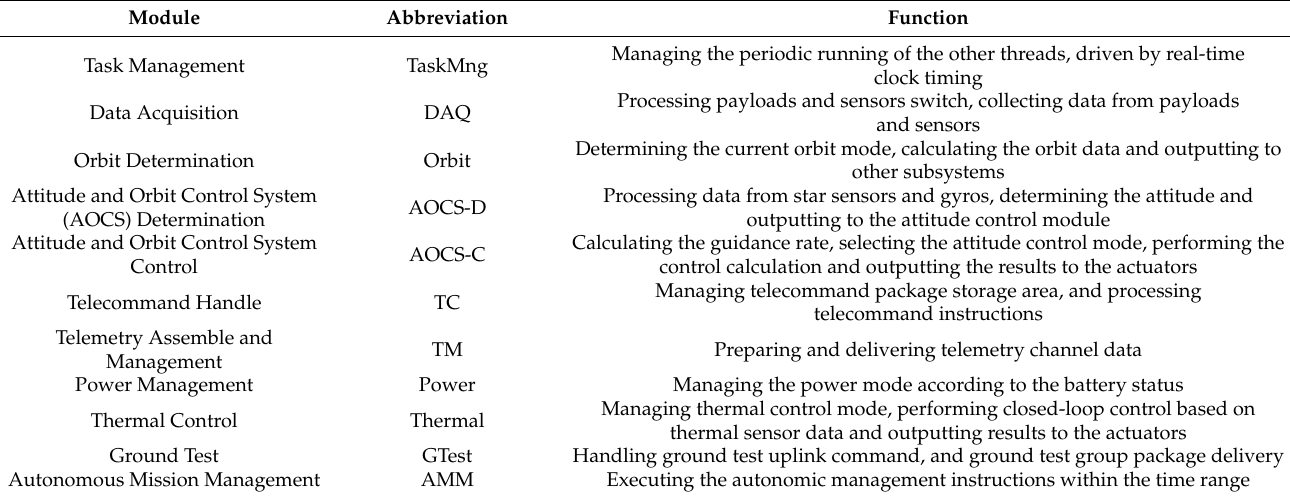
Table 2. Main modules of SMU